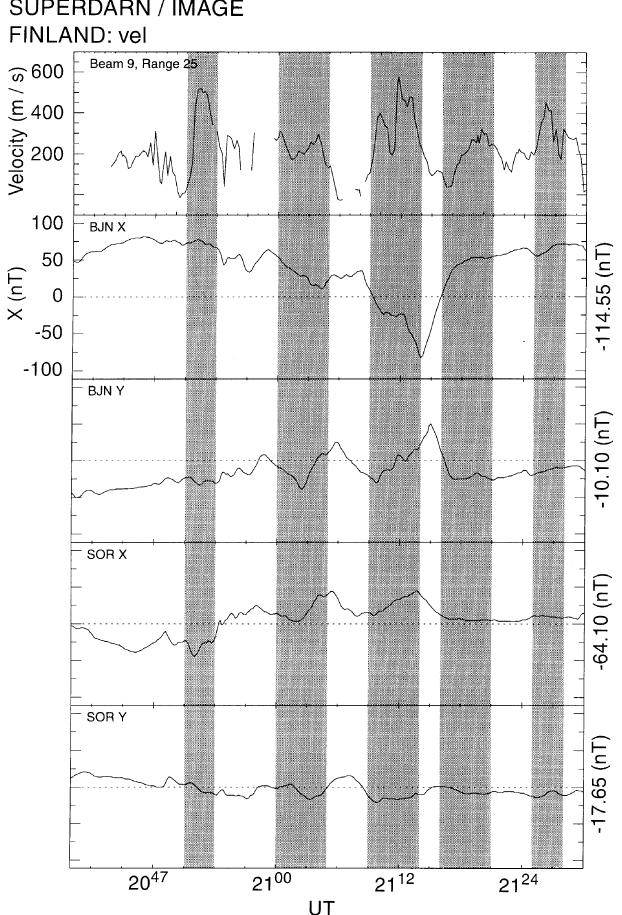
Fig. 4. Line of sight velocity data from beam 9, range gate 25 of the CUTLASS Finland radar ( top panel ) which approximately overlies BJN, and the X and Y components of the magnetic field measured at BJN and SOR. The times of equatorward velocity pulses are marked by shaded bars